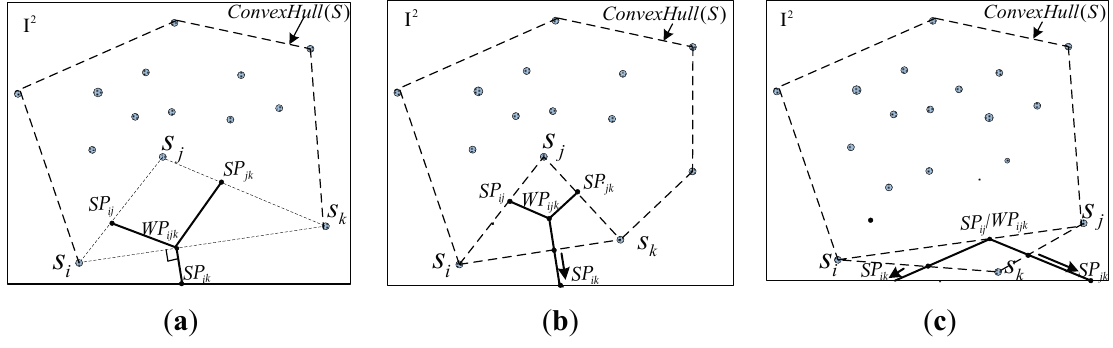
Figure 4. Extension of segment based on SDR ( a ) Two boundarynodes in